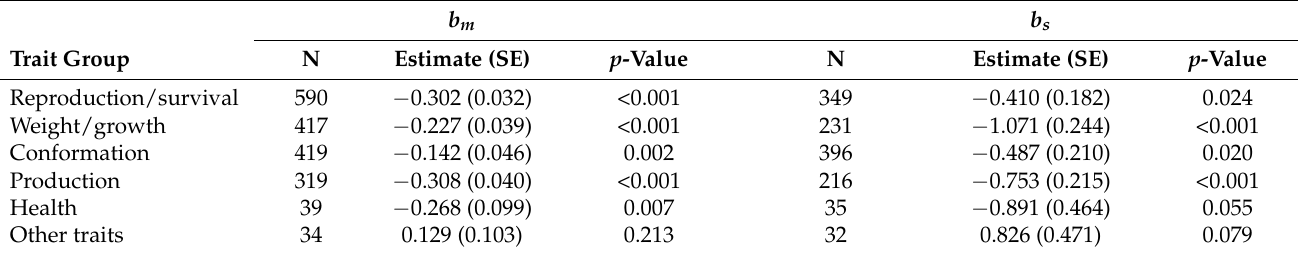
Table 1. Estimated marginal means of inbreeding depression estimates per trait group with standard errors (SEs). Inbreeding depression estimates are expressed as percentage of a trait’s mean ( b m ) or as percentage of a trait’s SD ( b s ). The number of estimates (N) and the p -value for testing the mean against zero are also shown.